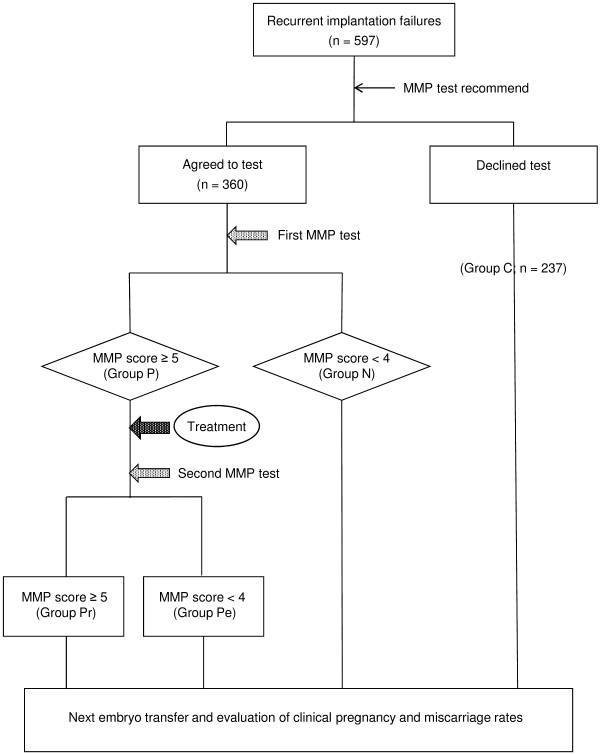
Flow chart of the study design. In all, 597 patients with RIF were recruited and divided into two groups based on whether or not they agreed to undergo the matrix metalloproteinase (MMP) test. Patients with MMP scores ≥5 were deemed to have a positive response (Group P) and were treated with a corticosteroid and an antibiotic for 2 weeks. Patients with low MMP scores (<5) were determined as negative (Group N). Patients in Group P were given a second MMP test after the treatment and were divided into two subgroups: Group Pr (patients who had again positive results and were considered as resistant to the treatment) and Group Pe (patients in whom the treatment was effective). Patients who did not undergo an MMP test comprised the control group (Group C). Patients in all groups underwent another embryo transfer procedure and the outcomes were compared among the four groups.